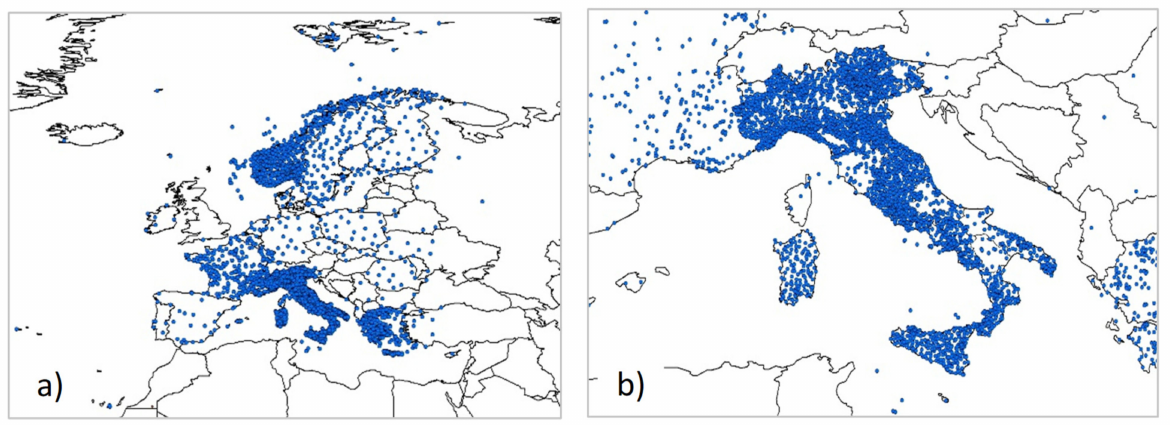
Figure 1. Geographical distribution of operational weather stations in the MNW database in Europe ( a ) and Italy ( b